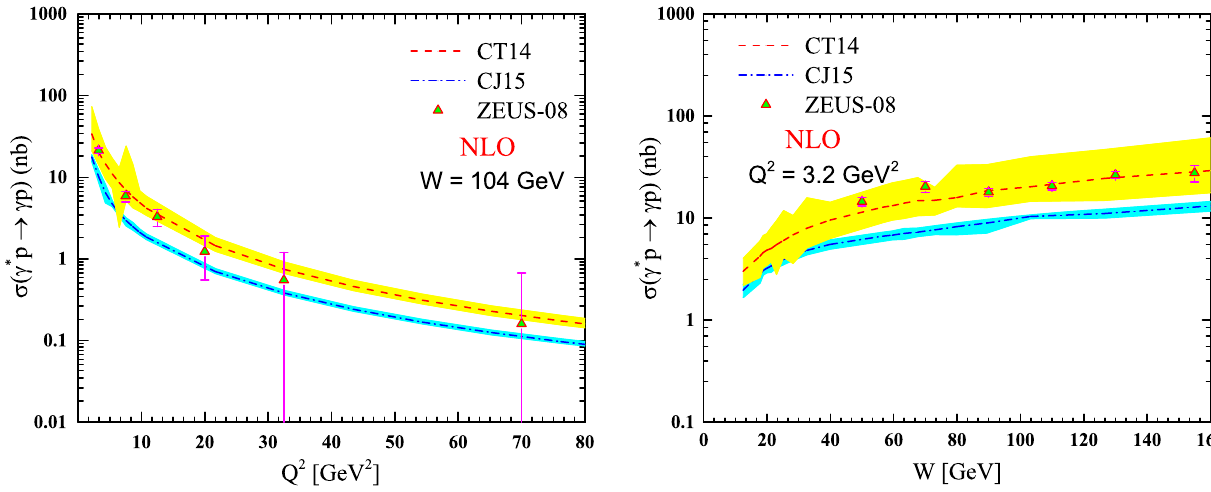
Fig. 9 The DVCS γ ∗ p → γ p cross section as a function of Q 2 (left) and W (right). Our NLO pQCD results are compared to the 2008 ZEUS data [81]; see for details Fig.